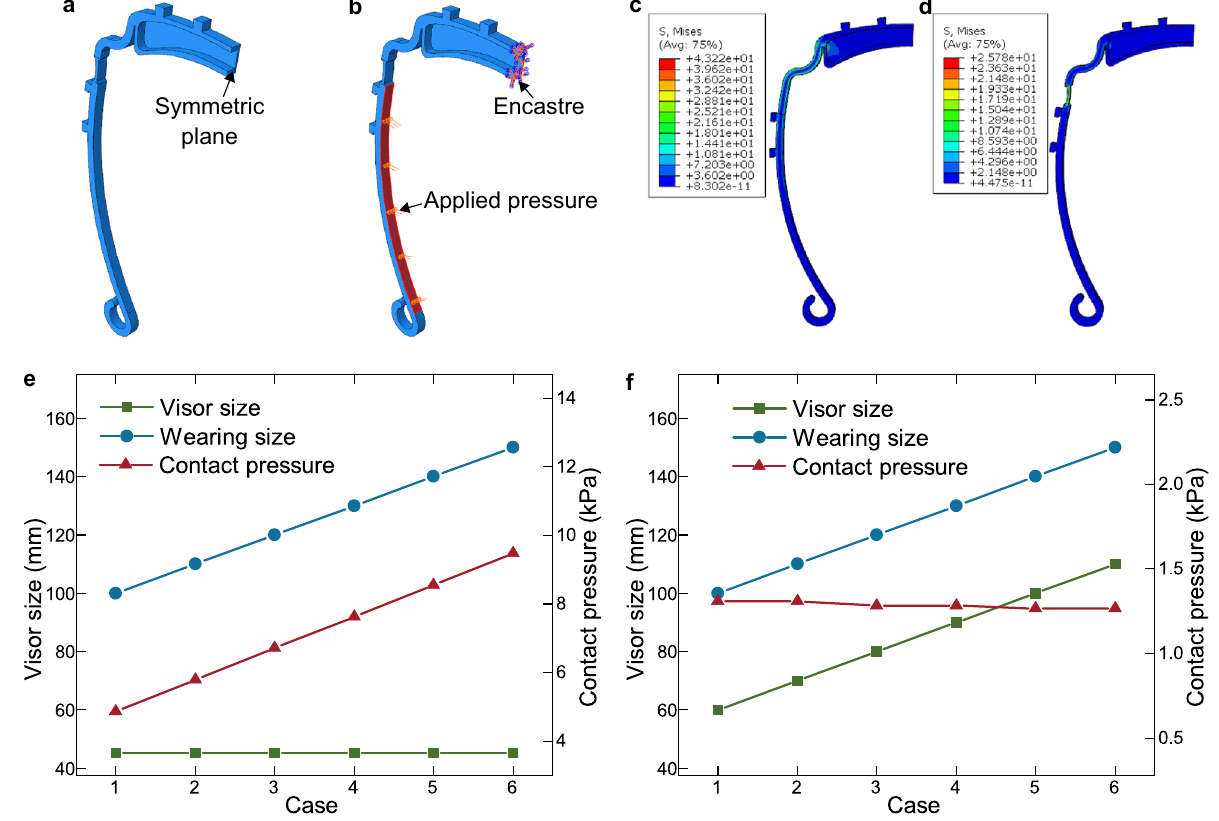
Figure 9. FEM analysis results of two visors. ( a ) Half of the visor frame for FEM analysis. ( b ) Boundary conditions and loading on the visor frame for simulation. ( c , d ) Stress distribution on the two visor frames for deforming to foot distance of 100 mm. ( c ) represents the original visor deformation and ( d ) represents the customized visor deformation with a customized foot distance of 60 mm. ( e ) Contact pressures from FEM analysis for different wearing sizes of the original visor frame. ( f ) Contact pressures from FEM analysis of the customized visor frame.